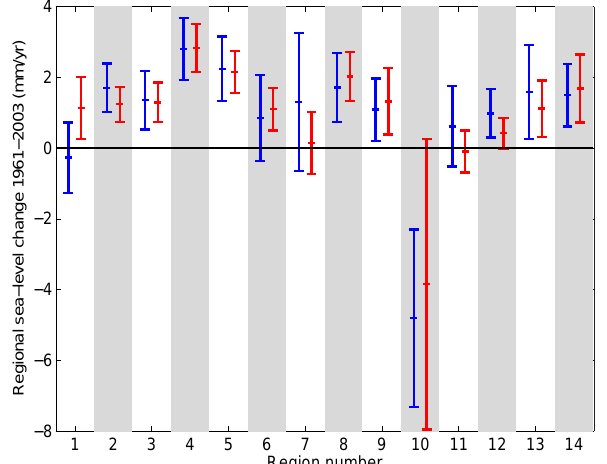
Figure 9a. Regional comparison of TG observations (blue) and as- sociated model points (red) (mmyr − 1 ), error bars indicate 1 σ stan- dard deviation within the regions. Region numbers as in Fig. 1.